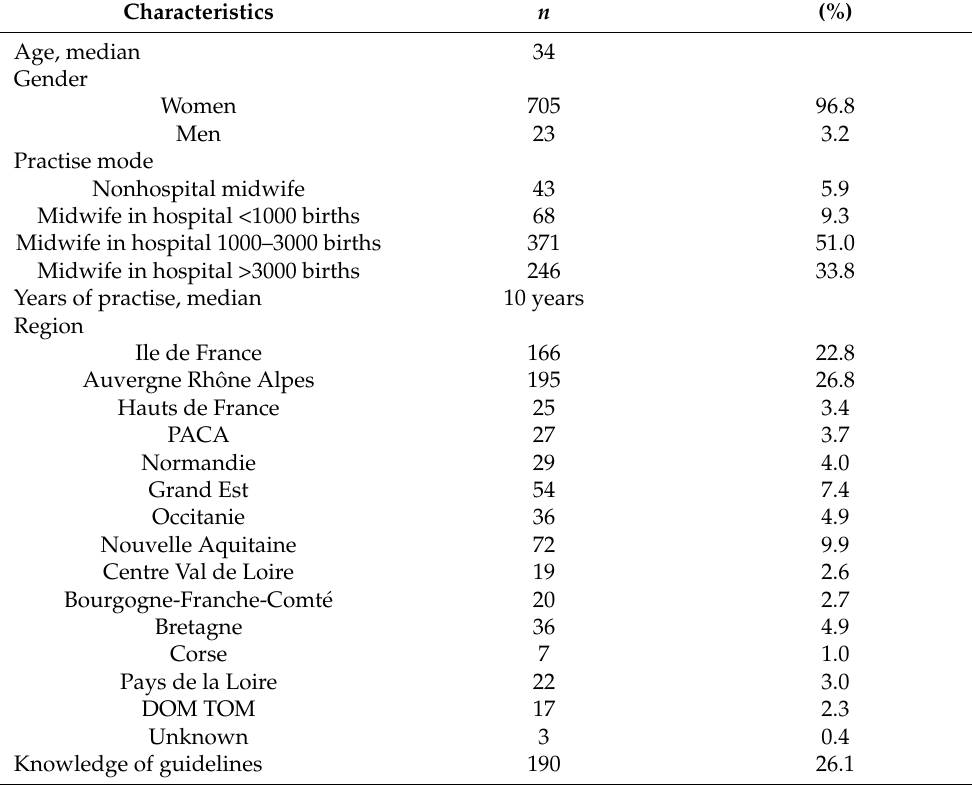
Figure 1. Flowchart. Table 1. Characteristics of the sample ( n =728).